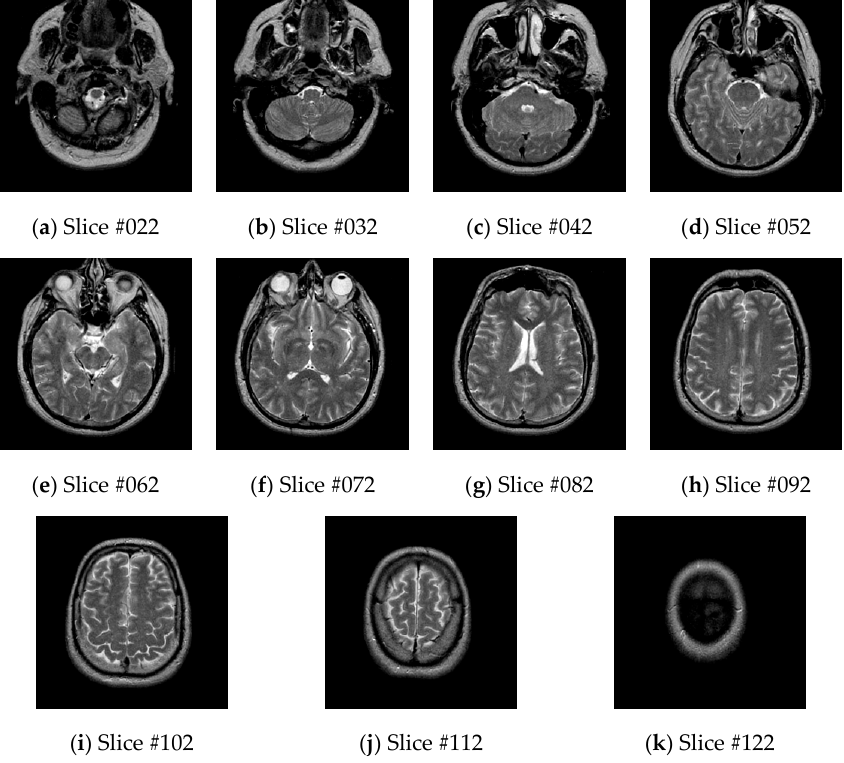
Figure 4. MR-T2 brain transaxial images.